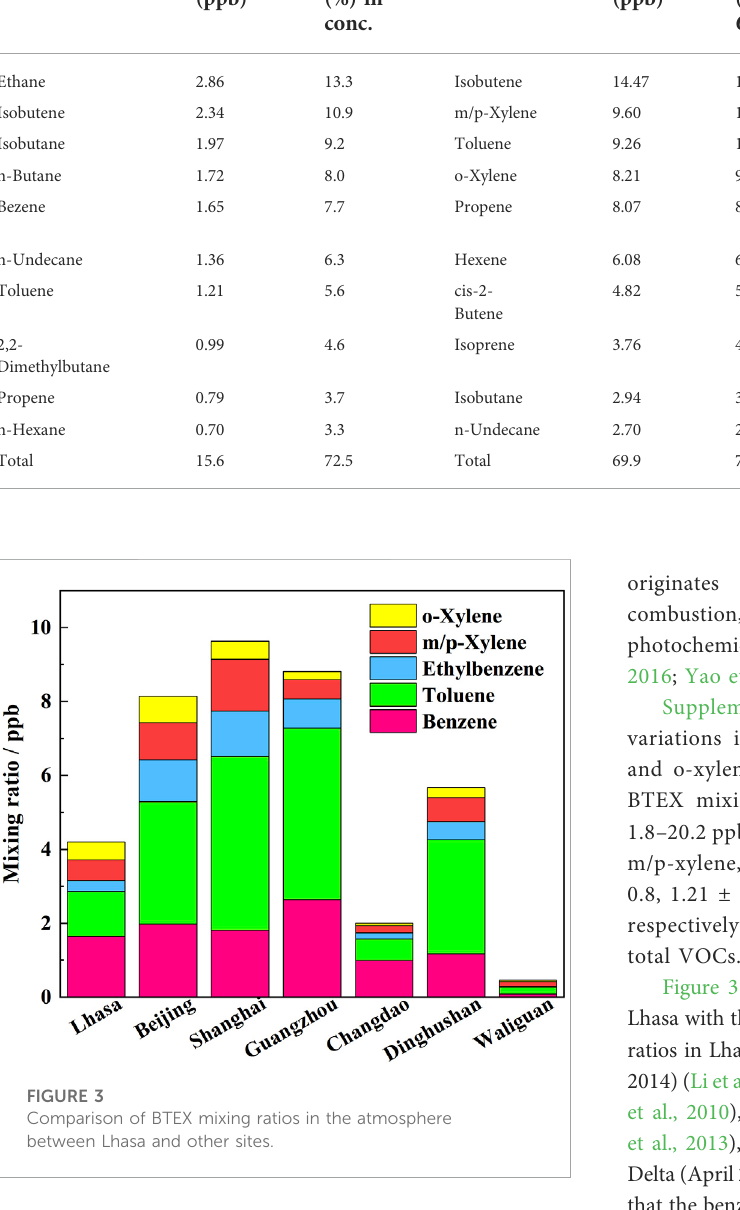
TABLE 3 Top 10 species ranked in terms of proportions of concentration, OFP , and L OH . Conc. (ppb)